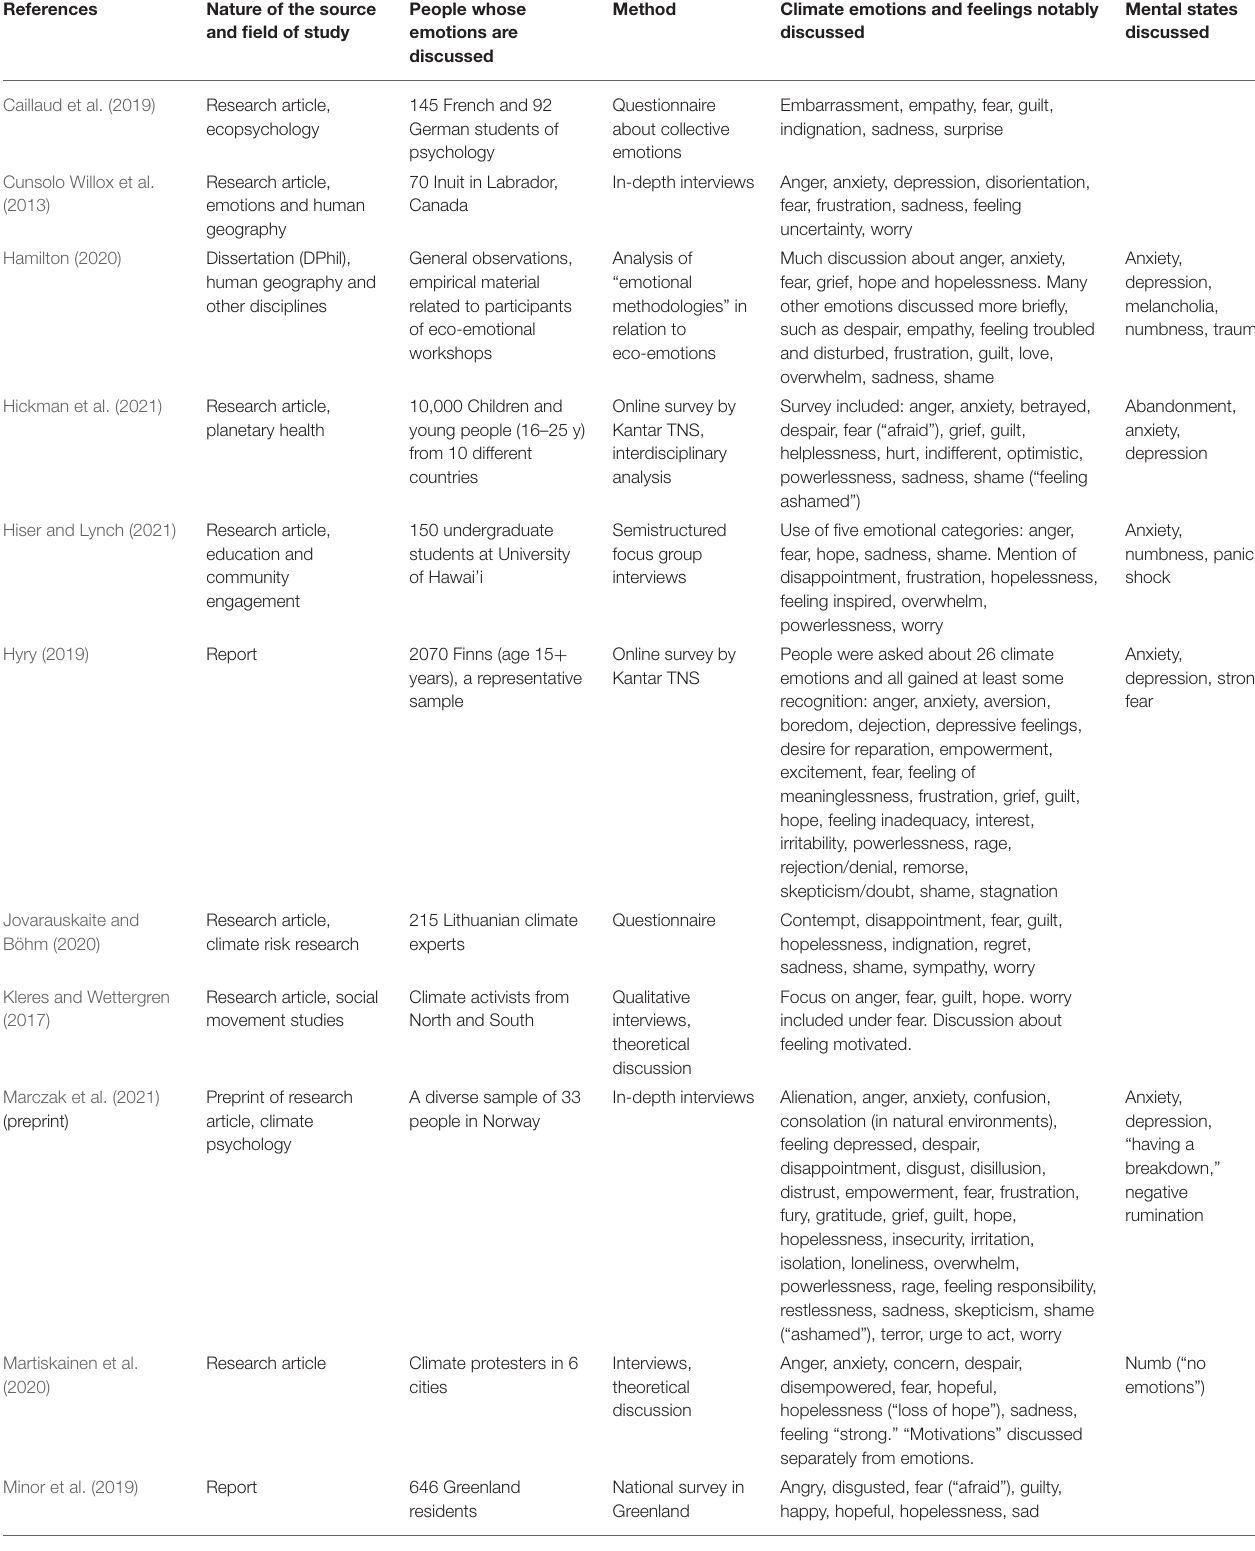
TABLE 1 | Climate emotions in key